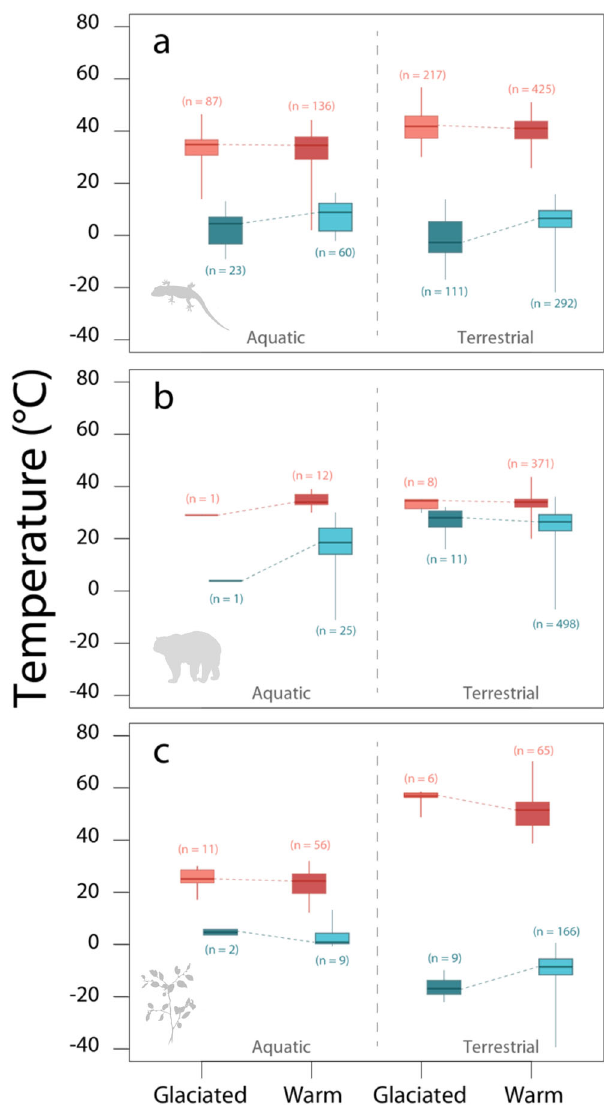
Fig. 2 Test of the effect of deep-time climate legacies. The boxplots compare the distributions of upper (red) and lower (blue) thermal tolerance of species belonging to orders of terrestrial and aquatic ( a ) ectotherms, ( b ) endotherms and ( c ) plants (photosynthetic plants and macroalgae). Dark colours re fl ect the palaeoclimatic conditions of order origination expected to show either lower values in lower thermal limits (darker blue for species belonging to orders originated under glaciated palaeoclimates — data from partial glaciated and glaciated paleoclimate categories combined) or higher values in upper thermal limits (darker red for species belonging to orders originated under warm non-glaciated palaeoclimates — warm and partial warm paleoclimate categories combined). For details on data collection see Supplementary Note 1. Boxes are bounded within the fi rst and third quartiles, medians represented by thick horizontal lines within each box and, whiskers extending to the minimum and maximum values that do not exceed 1.5 times the interquartile range from the median (provided by default in R function ‘ boxplot ’ ). Source data are provided as a Source Data fi